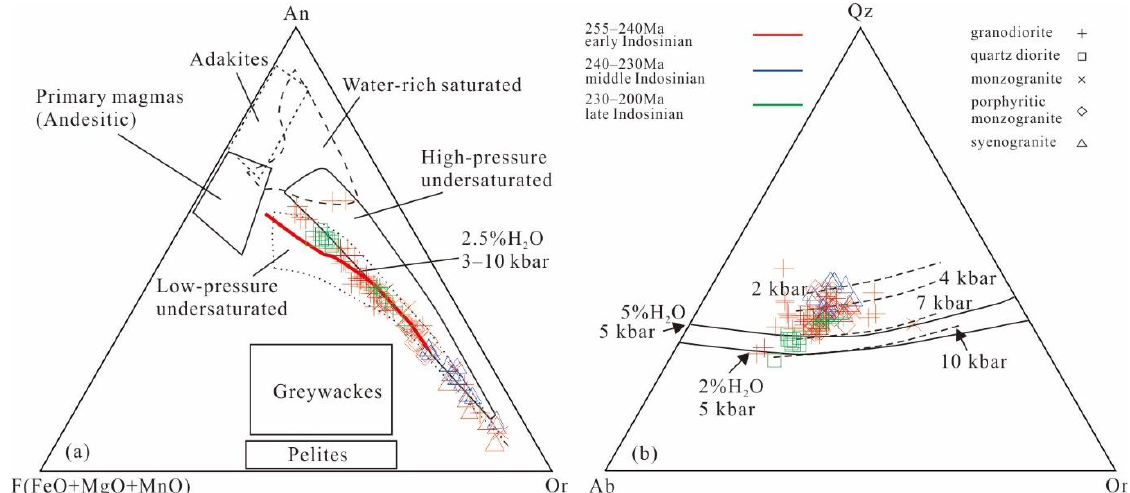
Figure 11. Diagrams of ( a ) F (FeO + MgO + MnO) – An – Or [60] and ( b ) Ab – Qz – Or (solid lines after [85]; dashed lines after [86]) for the Indosinian granite in the eastern region of the EKO. Qz = quartz, An = anorthite, Ab = albite, and Or = orthoclase.